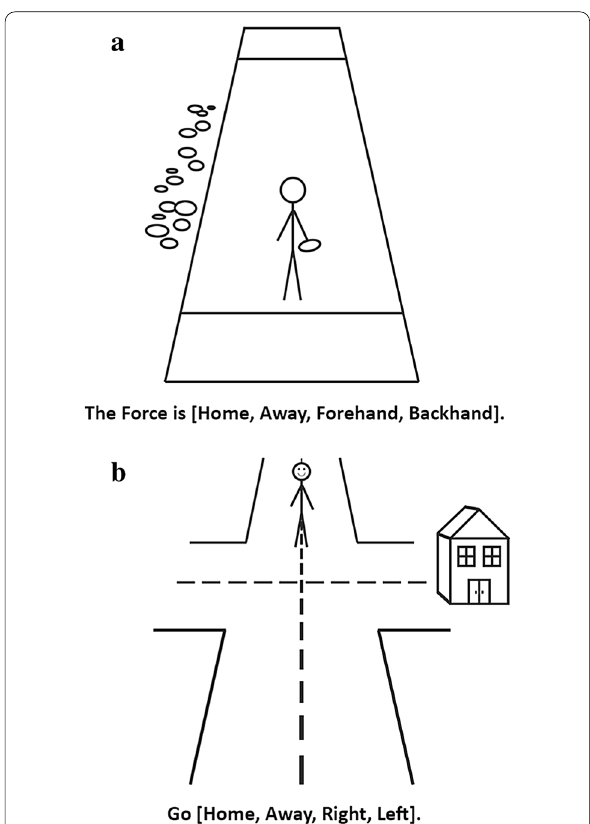
Fig. 1 Ultimate frisbee and road intersection task stimuli. Stimuli used in the ultimate frisbee ( a ) and road intersection ( b ) task. The text that appears below each image are the four possible prompts that participants saw (with one word in brackets selected for each trial). In both tasks, participants were instructed to treat the location of home as either the sideline with visual clutter (ultimate frisbee) or the direction of the house (road intersection). Variables for the task were: prompt (the text that appeared); the location of “home” (left or right); and location of the stick figure [near side as in ( a ) facing away from the participant, or far side as in ( b ) facing toward the